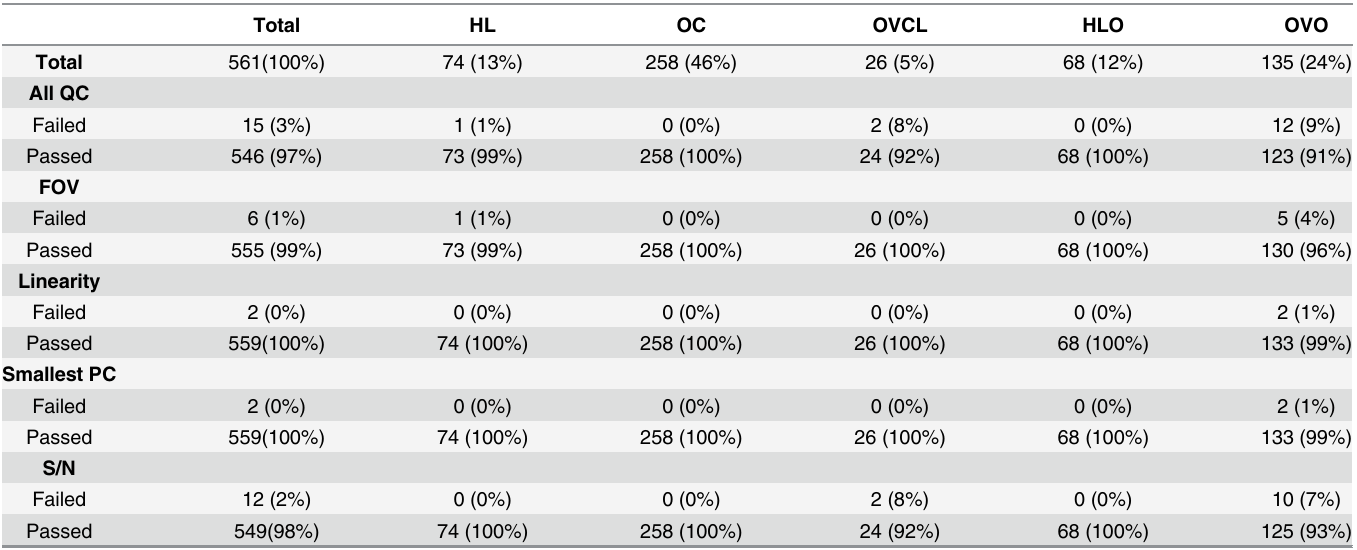
Table 2. Overall QC Measures by cohort.